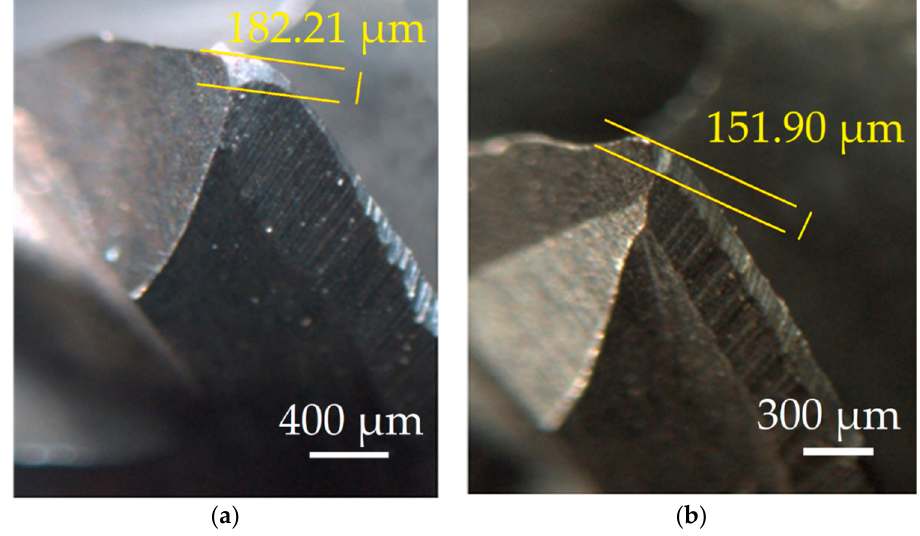
Figure 14. The size of the flank wear chamfer of end mills after 17.5 min of work when processing structural steel 41Cr4 with end mills; ( a ) uncoated, 182.21 μ m; and ( b ) with a single-layer DLC, 151.90 μ m.